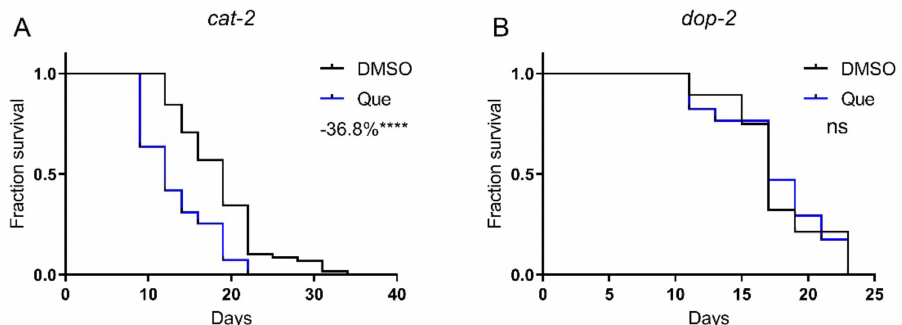
Figure 2. Quetiapine-mediated lifespan shortening is dependent on DOP-2. Survival curves of mutant cat-2 ( n = 60 worms per group) ( A ) and dop-2 ( n = 30 worms per group) ( B ) treated with 100 µ M of quetiapine or DMSO at 20 ◦ C. Data were analyzed by using log-rank test (ns: no significant difference with p > 0.05; ****: p < 0.0001). Experiments were performed in at least two independent biological